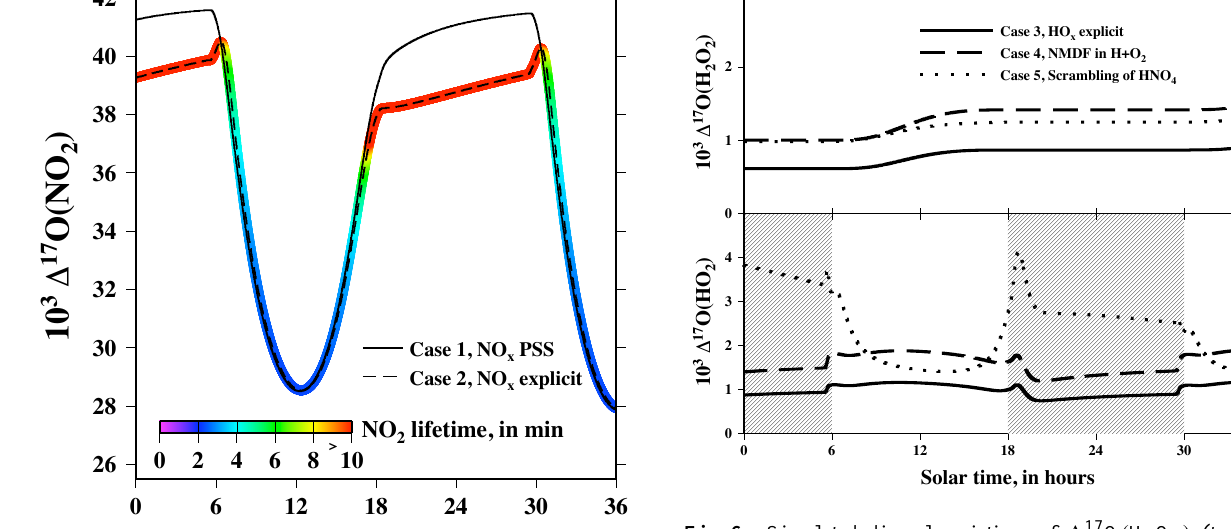
Fig. 6. Simulated diurnal variations of 1 17 O ( H 2 O 2 ) (top) and 1 17 O ( HO 2 ) (bottom) under the various hypotheses tested, from the results of the base model run. Note that in Case 1 and 2 (PSS and explicit NO x ), 1 17 O ( HO 2 ) is set to 0. The hatched area covers night-time periods when the presence of HO 2 in the atmosphere is insignificant, hence the relevance of its 1 17 O